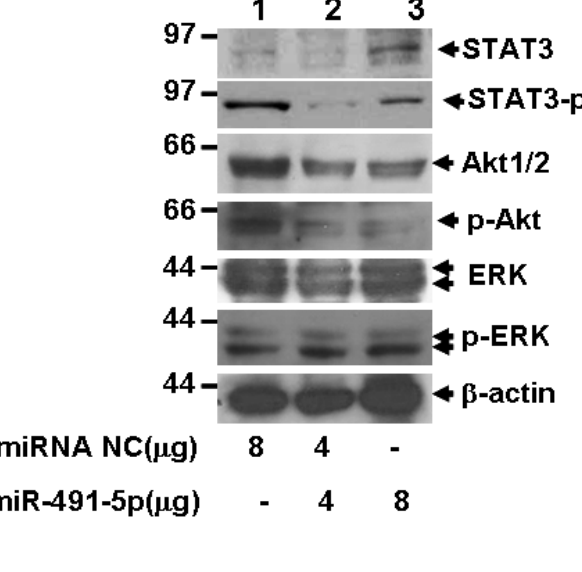
Figure 8. The potential signaling pathways affected by miR491-5p in SW1990 cells. Western blot analysis was performed using anti Akt, anti-phosphoryled Akt, anti ERK, anti-phosphorylated ERK, anti STAT3 and anti-phosphorylated STAT3 antibodies. Beta-actin gene expression was served as internal